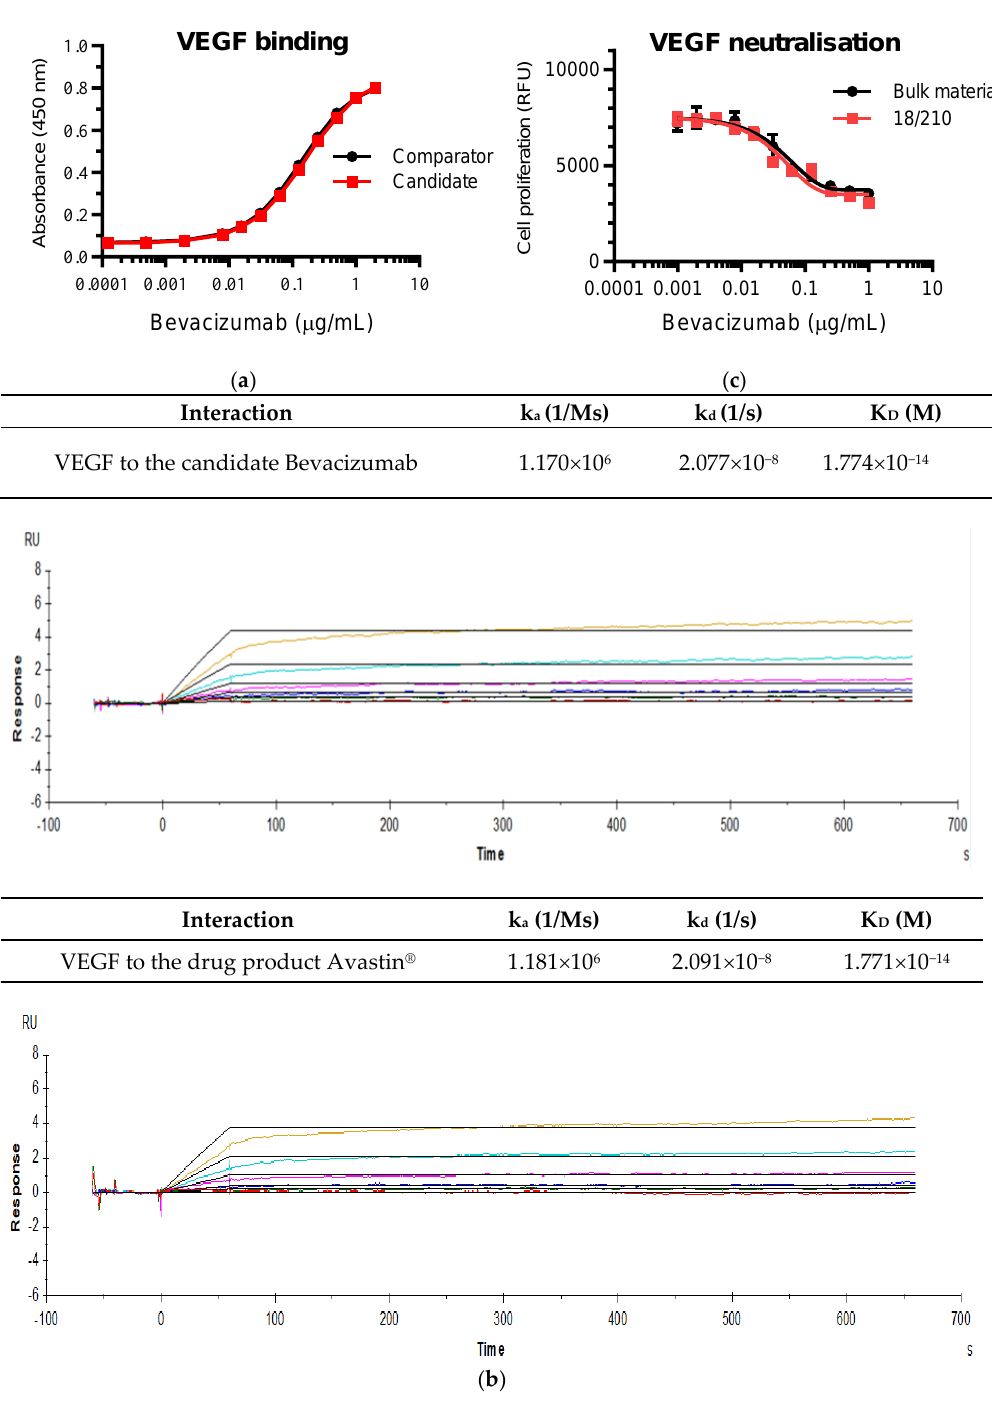
Figure 2. Binding activity of the candidate Bevacizumab bulk material and neutralising activity of the candidate preparation 18/210. ( a ) Direct binding by ELISA of the candidate Bevacizumab bulk material or the comparator Avastin ® to coated VEGF. Data for each point was represented as a mean and standard deviation (error bars) of three individual assay plates each containing samples in duplicate. ( b ) Surface plasmon resonance measurements of VEGF binding to captured Bevacizumab using a BIAcore T200 instrument (Cytiva, Uppsala, Sweden). Bevacizumab was captured by anti-human IgG-Fc antibodies immobilised on the chip surface, followed by sequential injections of VEGF (R&D Systems) at increasing concentrations over both the Bevacizumab-captured and the reference (non-Bevacizumab-captured) surfaces at a flow rate of 30 µ L/min at 25 °C. The binding sensorgrams were double referenced prior to global fitting of the increasing concentrations of VEGF (colour coded ranging from 0.156 nM to 5 nM) as both blank running buffer (no VEGF) and blank surface (no Bevacizumab) were used as references for background subtraction. Association and dissociation rate constants (k a and k d ) were